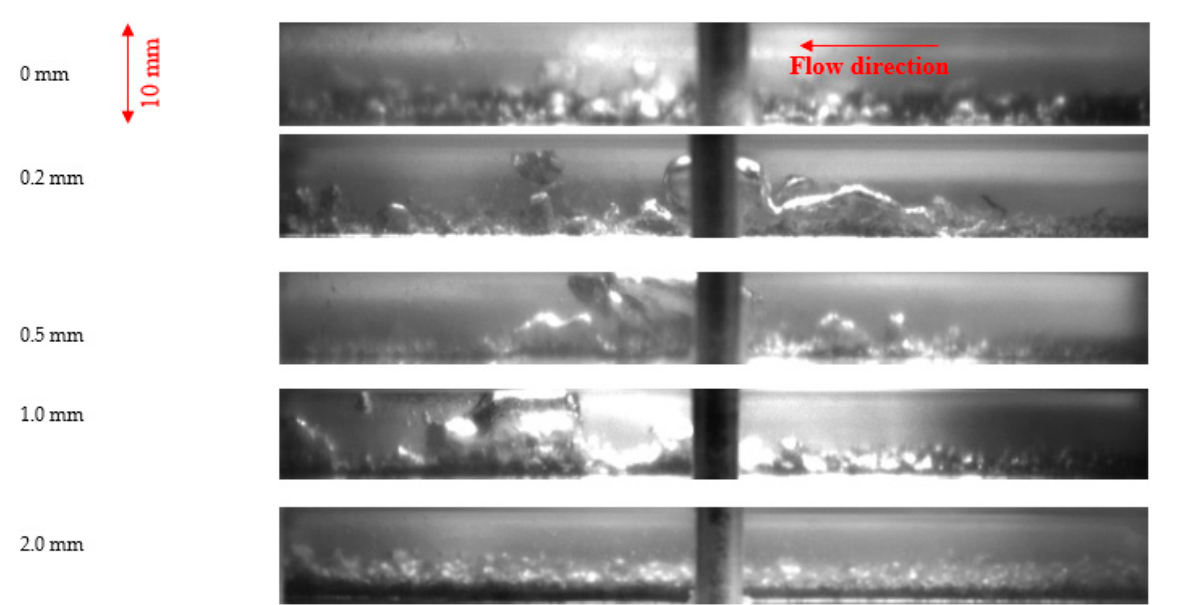
Figure 7. Flow and bubble formation pattern at the maximum heat flux for all the porous thickness: ∆𝑇 (cid:3046)(cid:3048)(cid:3029) = 30 K ; G = 400 kg·m − 2 s − 1 .